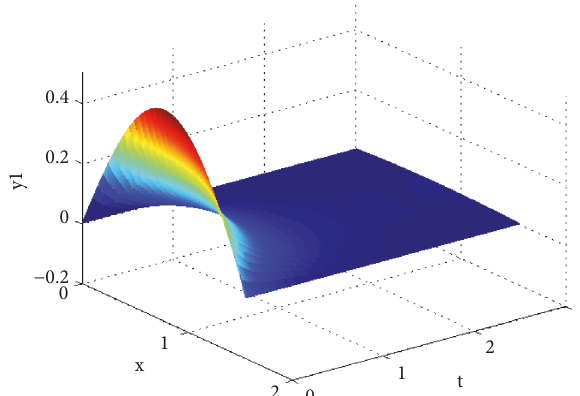
Figure 6: The closed-loop trajectory of 𝑦 1 (𝑥,𝑡) .